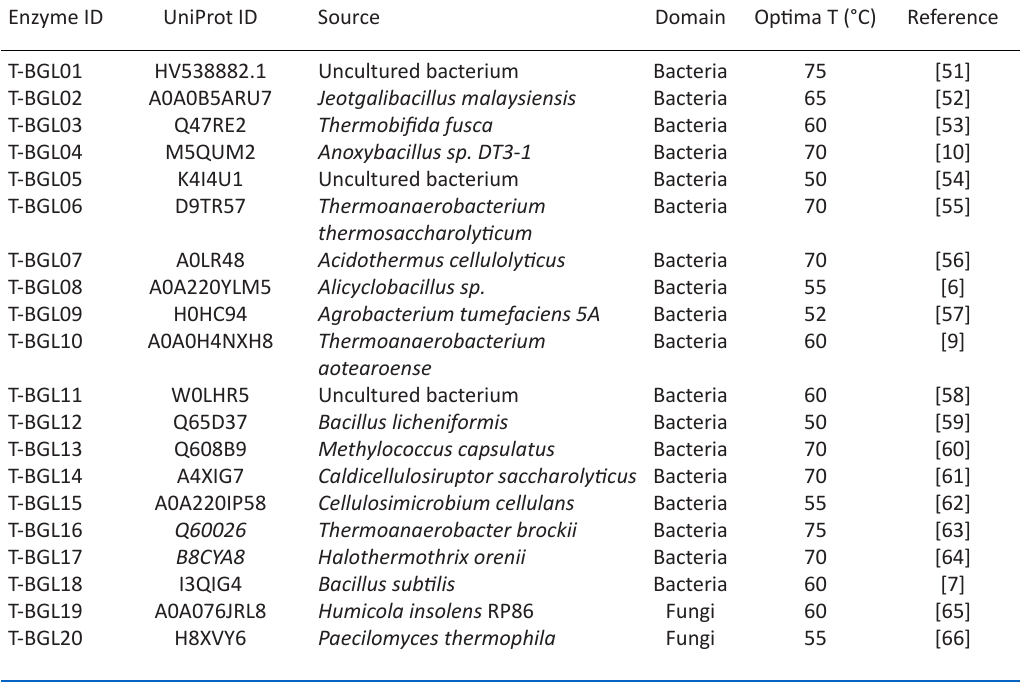
Table 2. Thermophilic GH 1 β -Glucosidase with UniProt ID and reported optimal temperature Enzyme